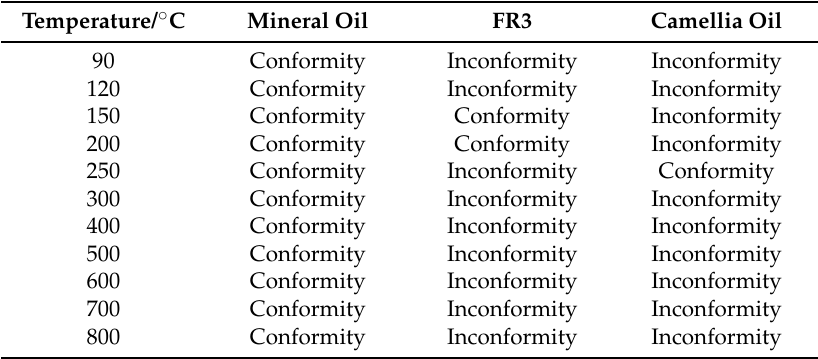
Table 8. Consistencies of diagnosis results and simulated fault types.